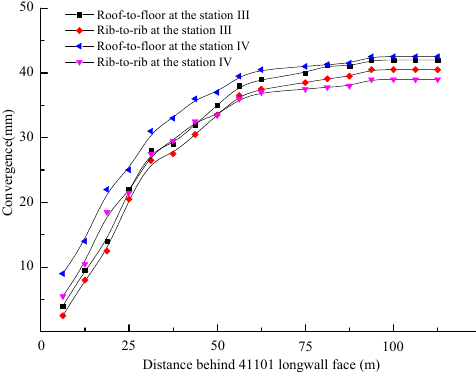
Figure 16. Deformation of surrounding rocks in backfill–truss supported roadway.